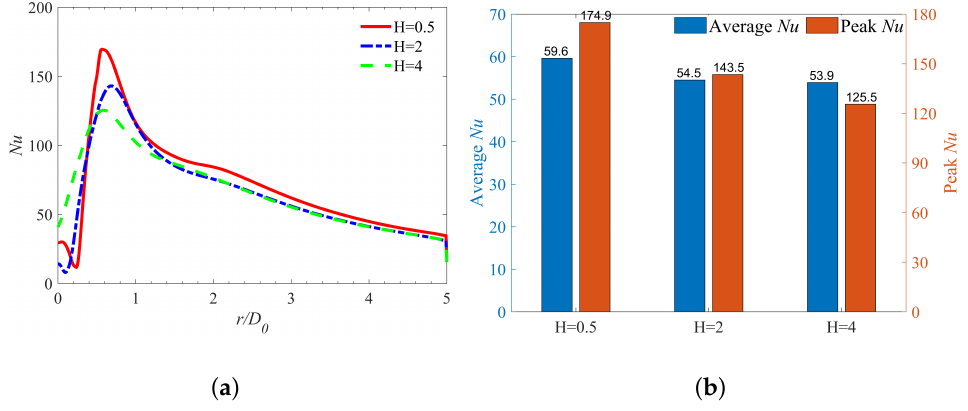
Figure 11 shows the local Nusselt distribution and total heat transfer performance of the impingement surface at three separation distances. The radial Nusselt number distribution over the target surface is shown in Figure 11a. With the presence of the recirculation zone near the surface, the Nusselt number plots of the cases at H = 0.5 and H = 2 show a similar trend: the Nu value is low in the axis, then decreases to the lowest magnitude of the Nu differs between these two cases, with a higher Nu value at H = 0.5.